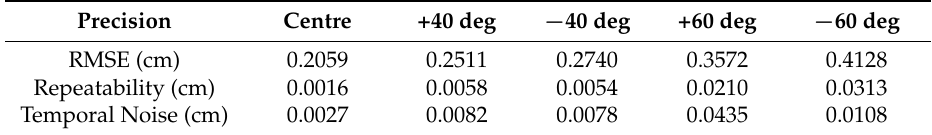
Table 3. Accuracy and precision of the Rambus Lensless Smart Sensor (LSS).